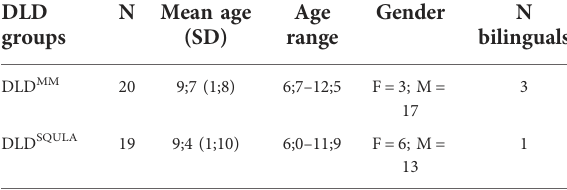
TABLE 1 Characteristics of training groups of participants with